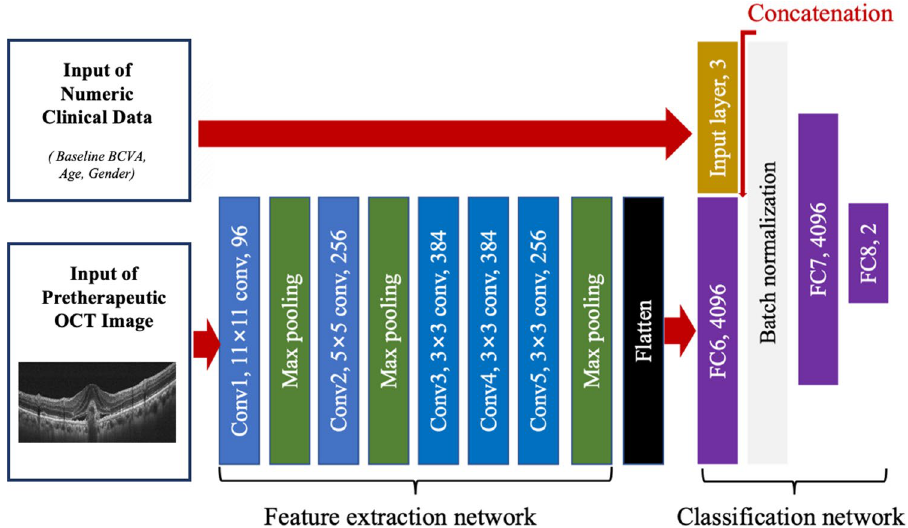
Figure 2. The architecture of HDF-Net. The feature extraction network consists of five convolution layers. The first convolutional layer has 96 kernels within the size of 11 × 11, presented as "Conv1, 11 × 11 conv, 96", while the second convolutional layer has 256 kernels within the size of 5 × 5, the third and fourth convolutional layer has 384 kernels within the size of 3 × 3, and the fifth convolutional layer has 256 kernels within the size of 3 ×